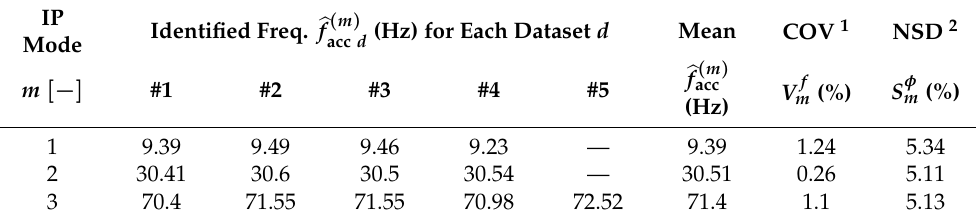
Table 2. Identified modal parameters based on